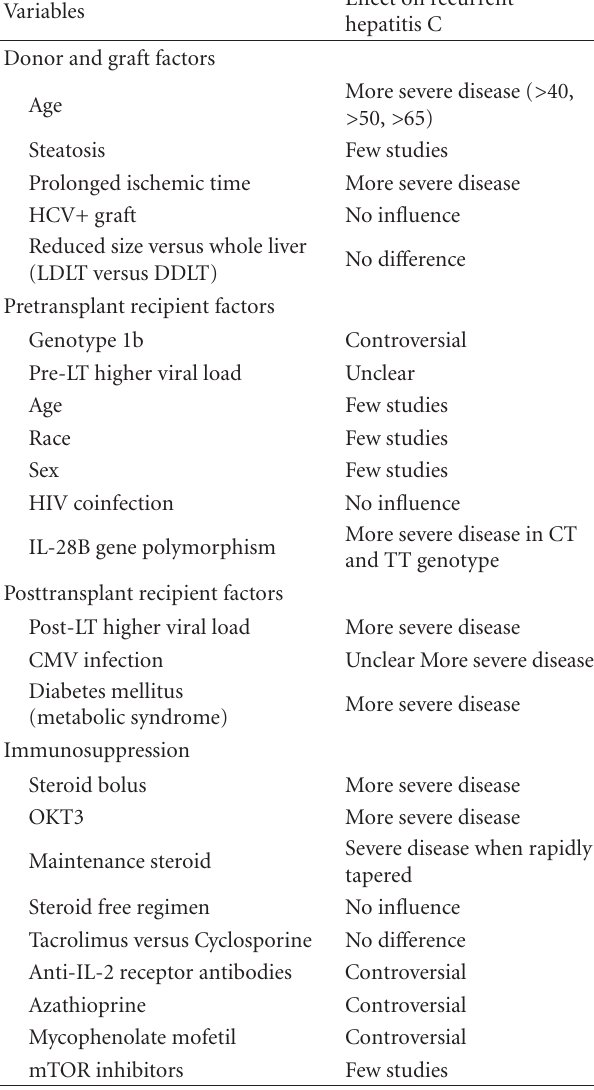
Table 1: Factors associated with the severity of recurrent hepatitis C after liver